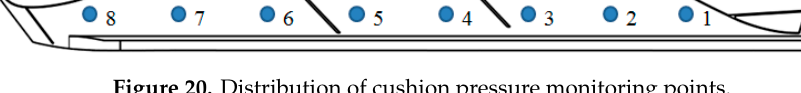
Figure 20. Distribution of cushion pressure monitoring points.